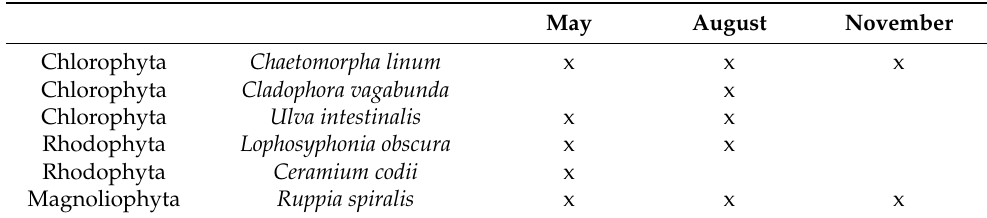
Table 5. Floristic list of submerged vegetation species observed between May and November 2021 in the Burano